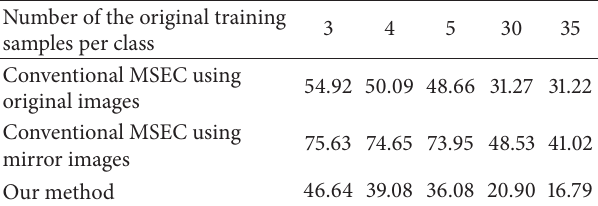
Table 2: Rate of classification errors (%) on the Yale B